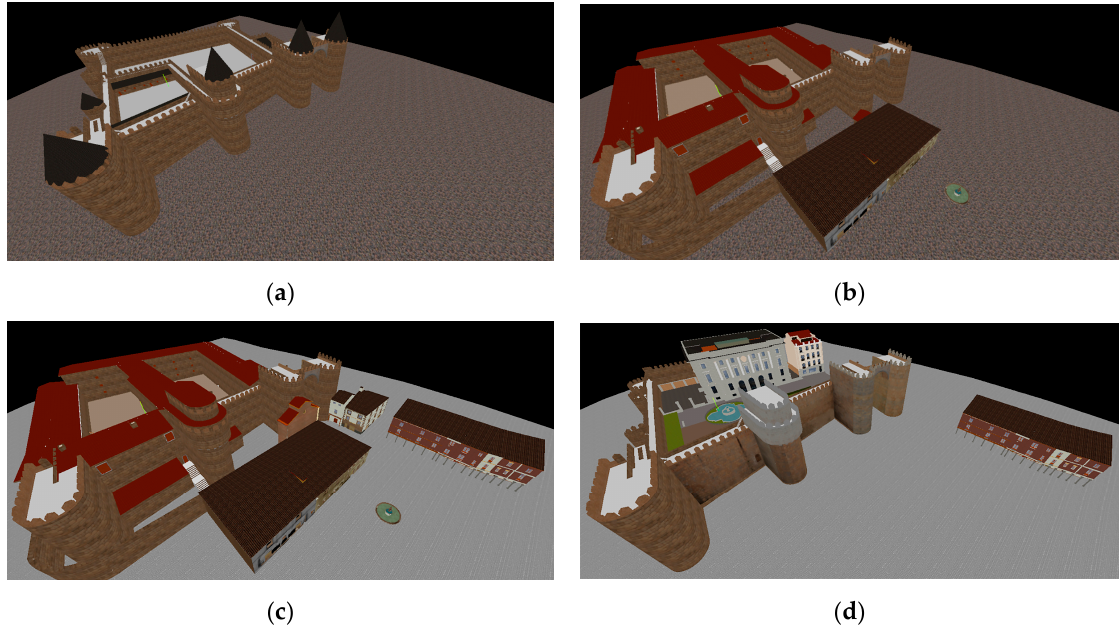
Figure 16. Rendering of the scenarios considered for the different performance tests carried out: ( a ) Scenario A; ( b ) Scenario B, ( c ) Scenario C; and ( d ) Scenario D.